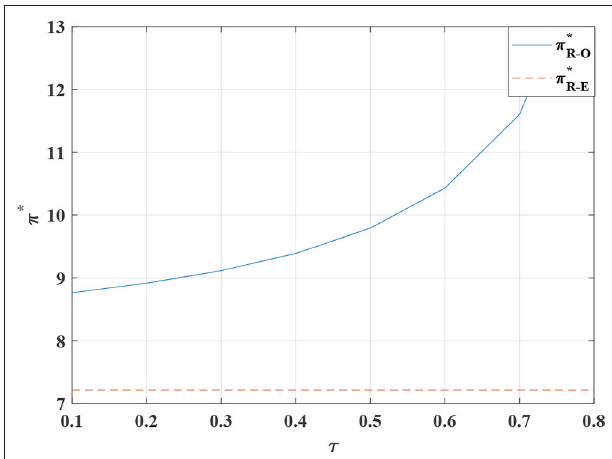
FIGURE 15 | The influence of τ on the retailer’s optimal profit.